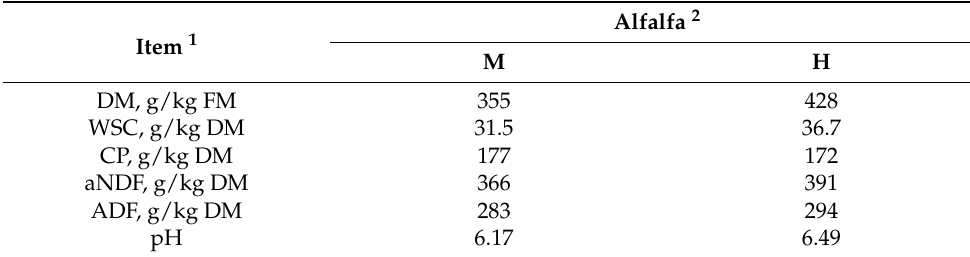
Table 1. Chemical composition of alfalfa prior to ensiling ( n =